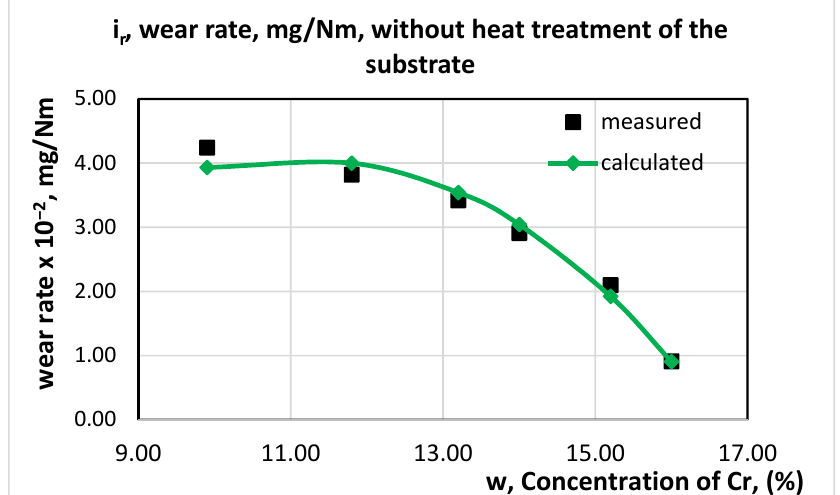
Figure 16. Analytical dependences of the wear rate on the chromium concentration for coatings without heat treatment, i r ( w ) = − 0.00599819 w 3 + 0.099501902 w 2 .